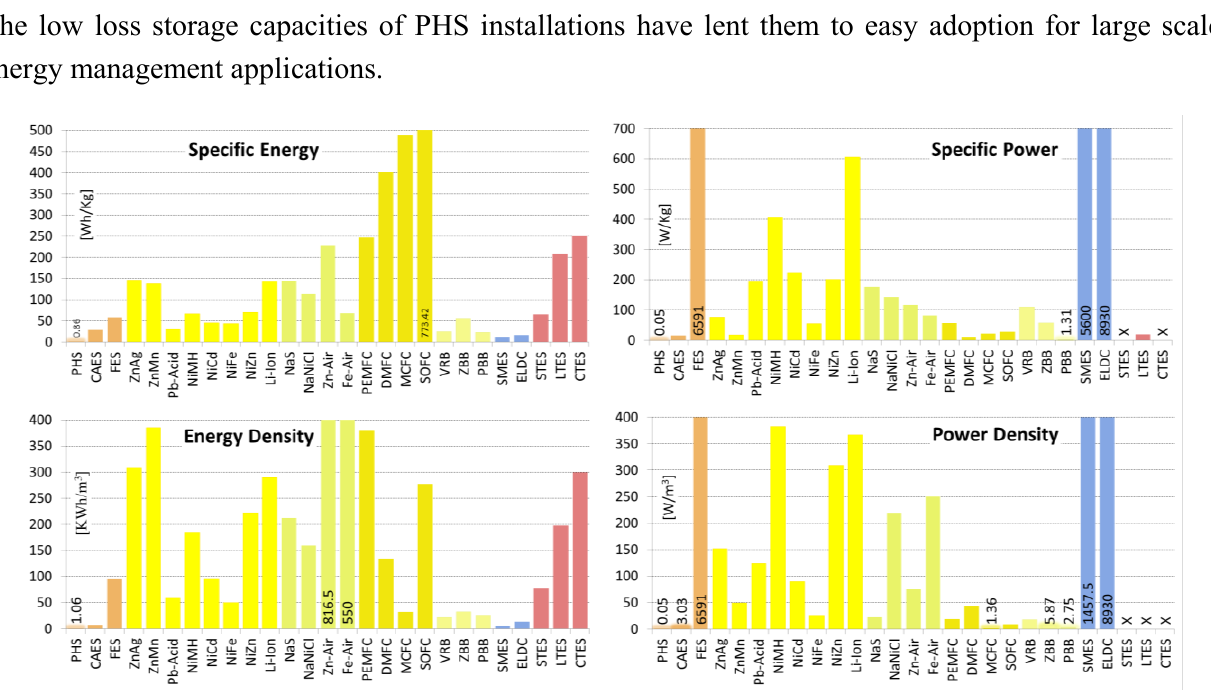
Figure 12. Energy and power performance of storage devices with respect to each other. Note that data points with “X” marks are